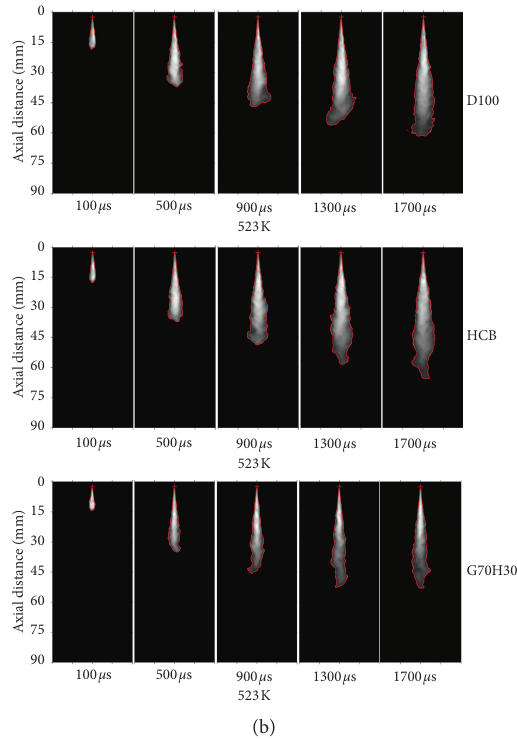
Figure 3: Liquid phase development versus time for D100, HCB, and G70H30 fuels under 323K, 423K, and 523K.